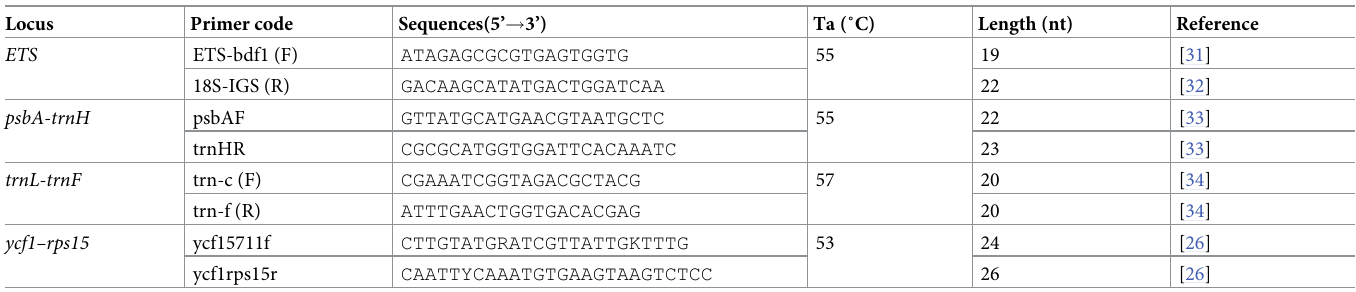
Table 2. Primers used in this